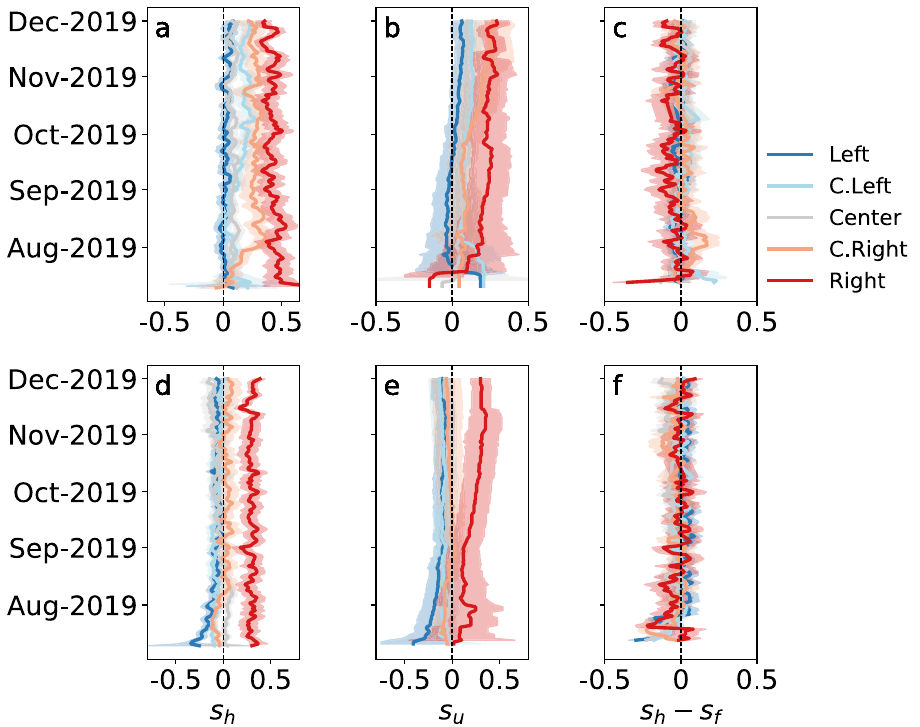
Fig. 5 Time series of political alignment. Negative alignment scores mean Left-leaning and positive scores mean Right-leaning. Alignment scores s h are calculated from content to which drifters are exposed in their home timelines, based on hashtags ( a ) and links ( d ). Alignment scores s u are calculated from content expressed by the drifter posts in their user timelines, based on hashtags ( b ) and links ( e ). The difference s h − s f measures news feed bias experienced by drifters, where the political alignment score s f is derived from the content generated by friends , based on hashtags ( c ) and links ( f ). Missing values are replaced by preceding available ones. Colored con fi dence intervals indicate ± 1 standard error. Source data are provided as a Source data fi le. Plots for each individual drifter are in Supplementary Figs. 2 –